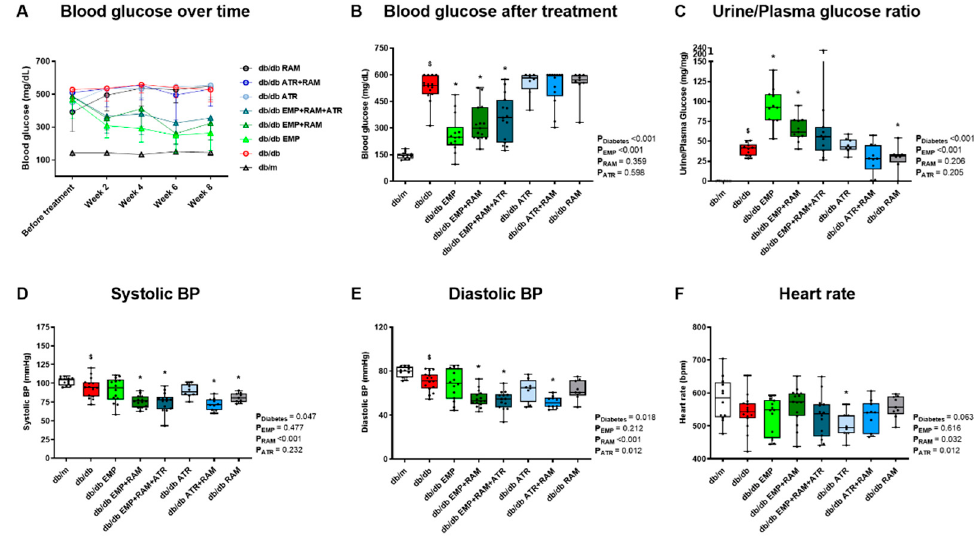
Figure 1. Blood glucose, urine glucose, blood pressure (BP), and heart rate of vehicle-treated db/m mice, vehicle-treated db/db mice, and db/db mice treated with empagliflozin, atrasentan, ramipril, or their combinations . ( A ) Mean blood glucose over time in mg/dL. Error bars display standard deviation (SD). ( B ) Blood glucose (mg/dL) after 8 weeks of treatment. ( C ) Urine glucose to plasma glucose ratio at the end of the treatment. ( D ) Systolic blood pressure in mmHg. ( E ) Diastolic blood pressure in mmHg. ( F ) Heart rate in bpm. db/m : non-diabetic mice treated with vehicle. db/db : diabetic mice treated with vehicle. db/db EMP : diabetic mice treated with empagliflozin. db/db EMP + RAM : diabetic mice treated with empagliflozin and ramipril. db/db EMP + RAM